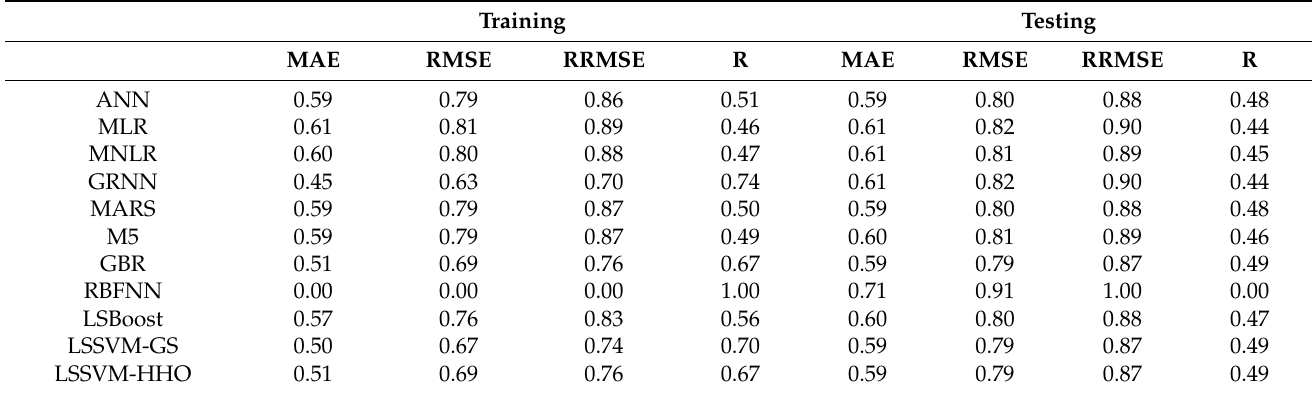
Table A5. Results of modeling WS with the base algorithms at the Neyshabur station.